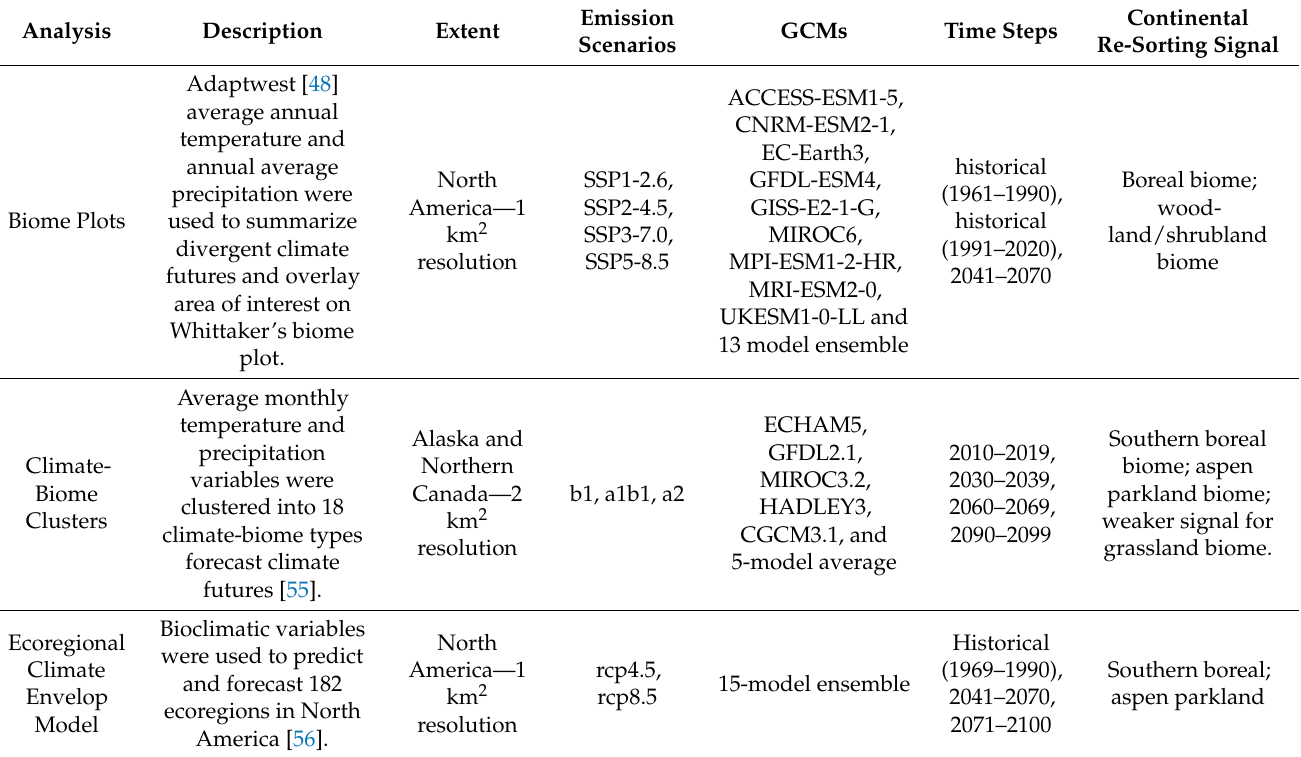
Table 1. Three analyses used to assess Continental re-sorting on the Tetlin National Wildlife Refuge with publicly available datasets. Each analysis used different methodologies and climate scenarios. Emission scenarios are listed from low to